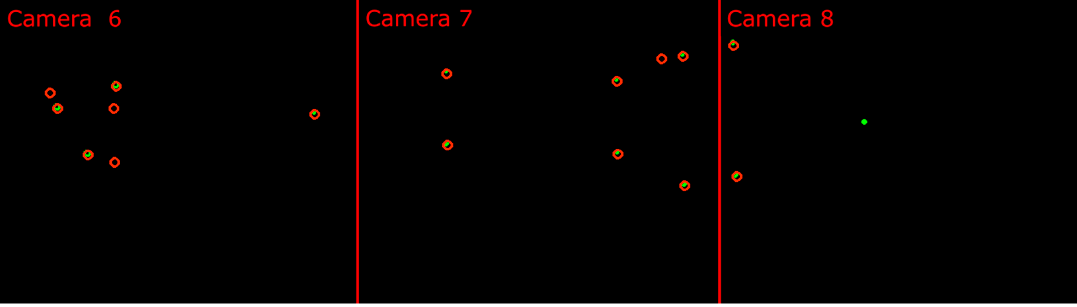
Figure 6. Images of three cameras used for pose initialization. Green dots are markers detected by the cameras, while the red circles are projected points based on the pose and the known 3D marker coordinates.